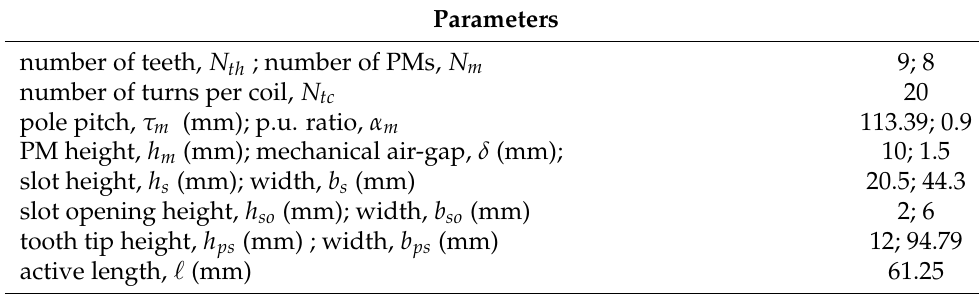
Figure 4. ( a ) Machine case of study and winding setup: - Each phase coil wound around a single tooth is identified with a capital or small letter indicating that it is positively or negatively wrapped towards y according to the right hand rule. ( b ) Zoom with main sizes: - slotless: zones A (cid:13) and B (cid:13) both filled with iron. - slotted: zone A (cid:13) filled with iron and B (cid:13) with air. Table 1. Machine main